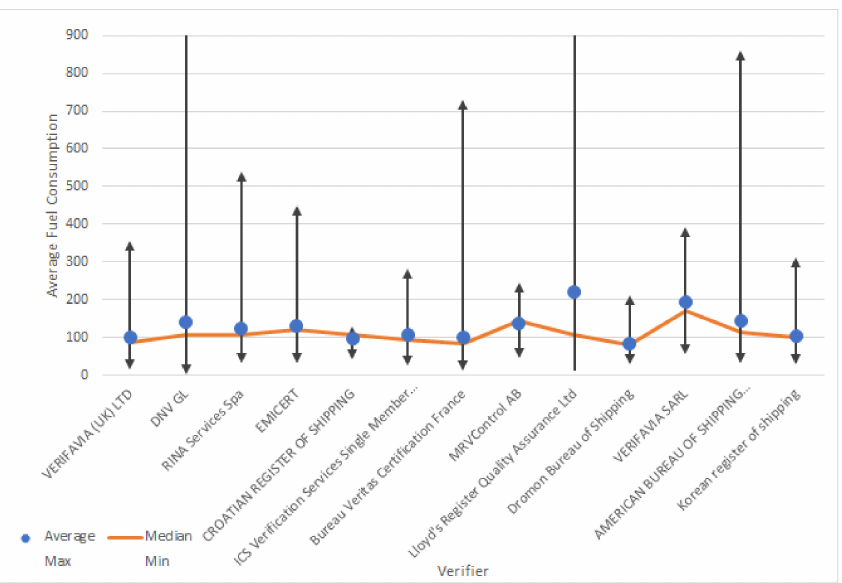
Figure 3. Differences in fuel consumption data (kg/nm) grouped by the different third-party verifiers shown by average (blue), median (orange), maximum and minimum values